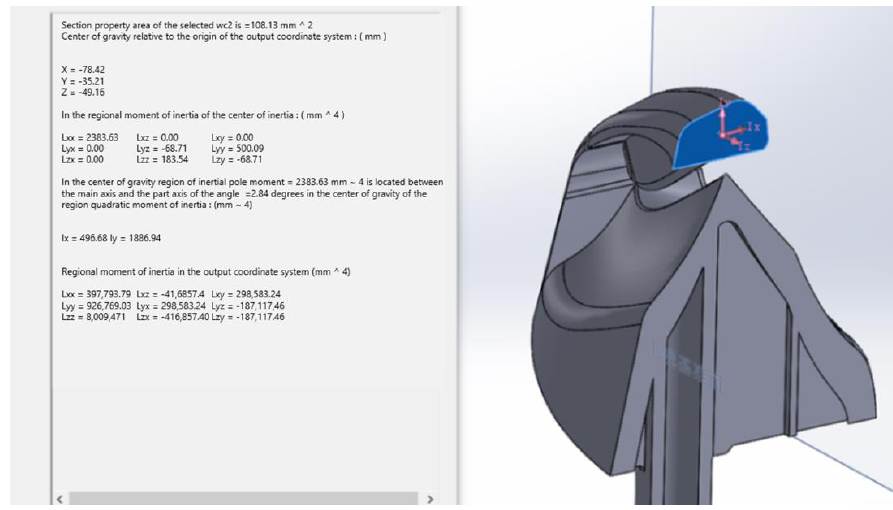
Figure 5. Resolution of the 0.46 radius theoretical stress concentration factor.